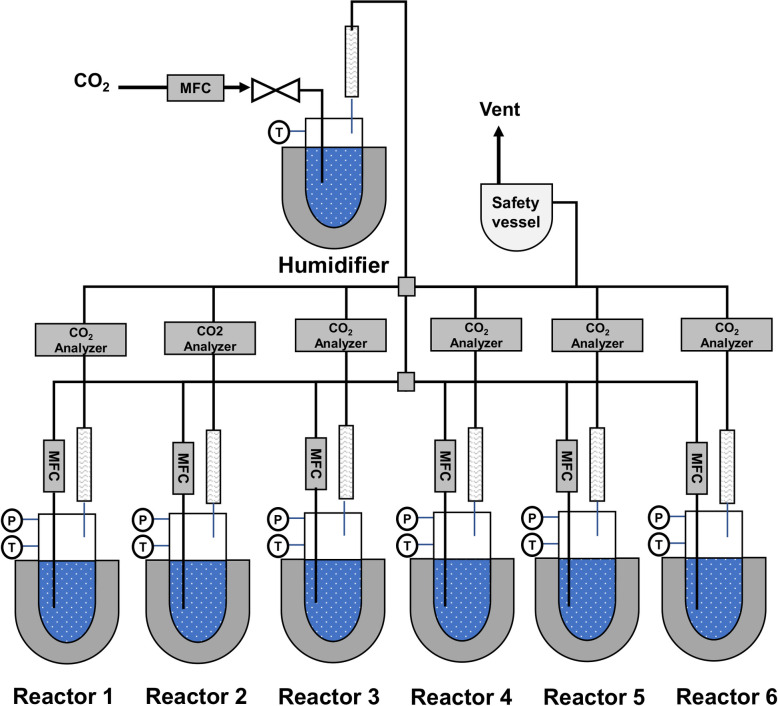
Schematic diagram of CO2 absorption apparatus [29].(MFC stands for mass flow controller).